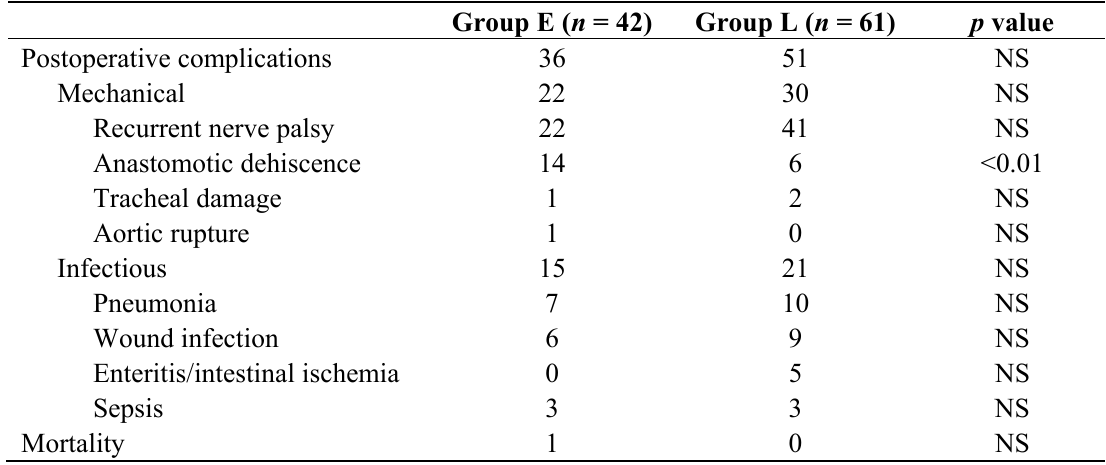
Table 2. Postoperative complication and Mortality: Early versus Late EN ( n = 103).p